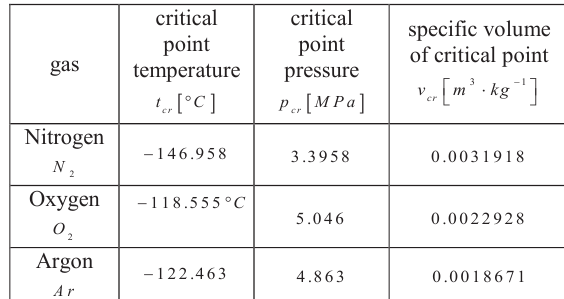
Table 3. Parameters of the critical point cr of dry air components [2].